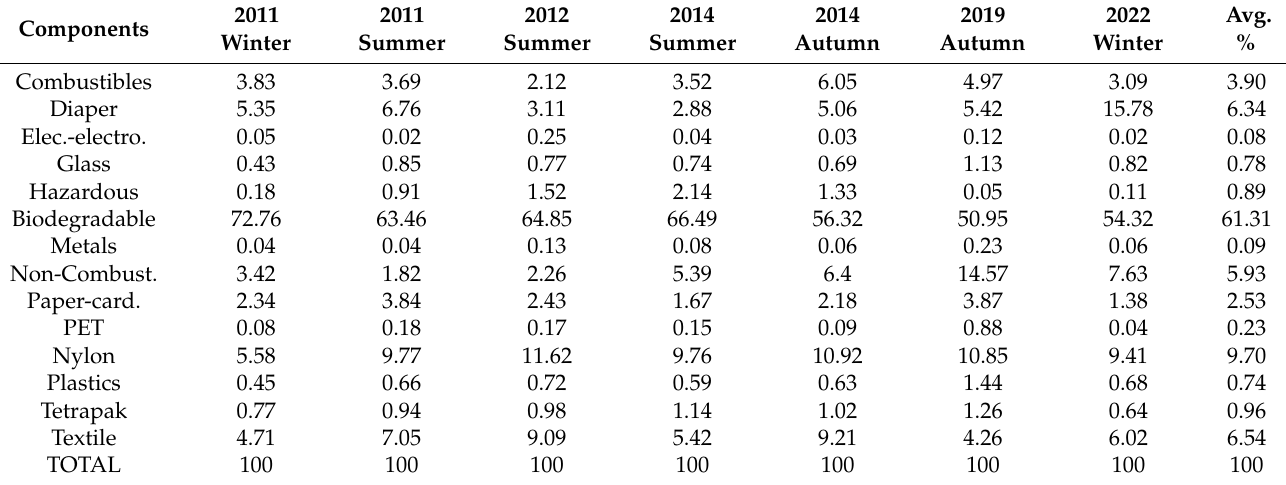
Figure 8. Current waste management system in Lahore (Business As Usual). Table 3. Composition of solid waste over the period